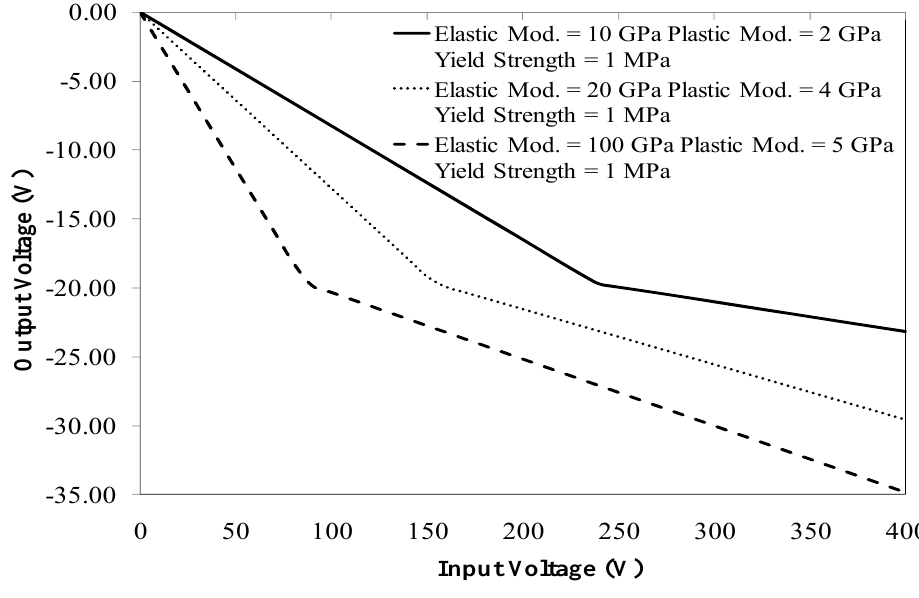
Figure 13. Induced voltage resulting from applied voltage for a range of test specimen